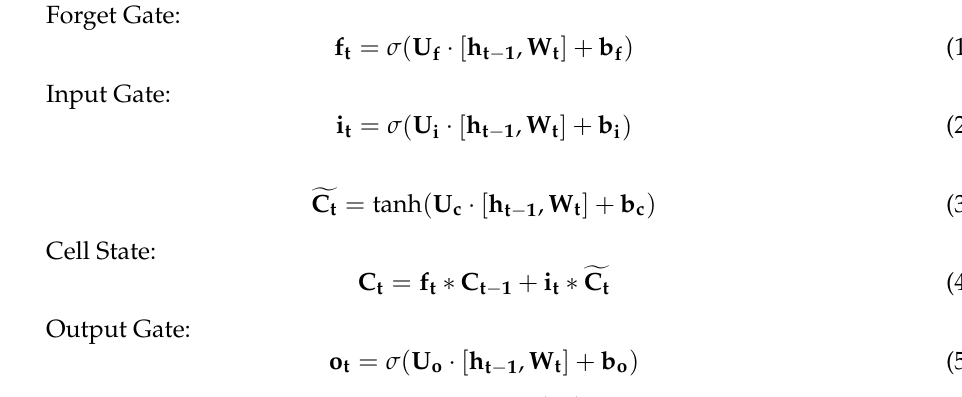
Figure 7. LSTM model diagram